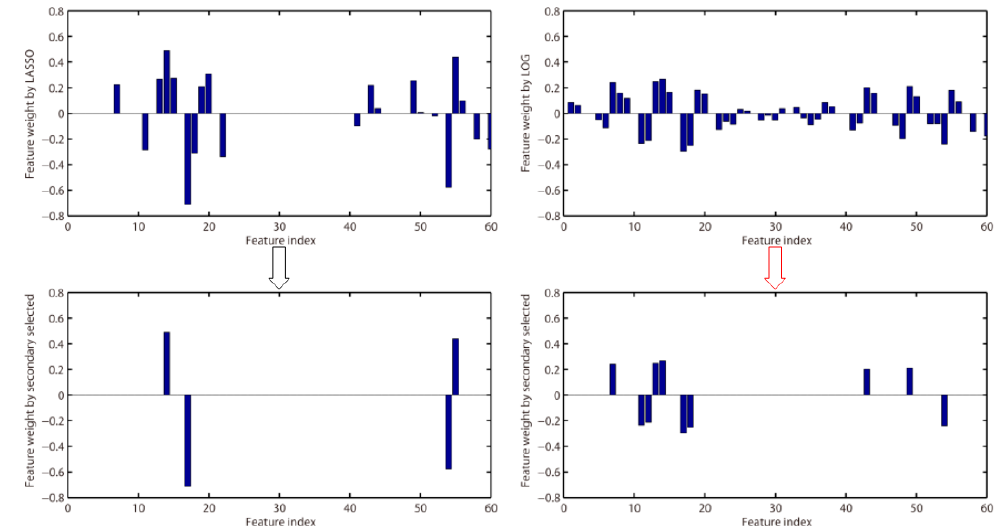
Figure 8. Feature selection by LASSO and LOG for subject A01 with motor imagery tasks of left hand vs right hand.